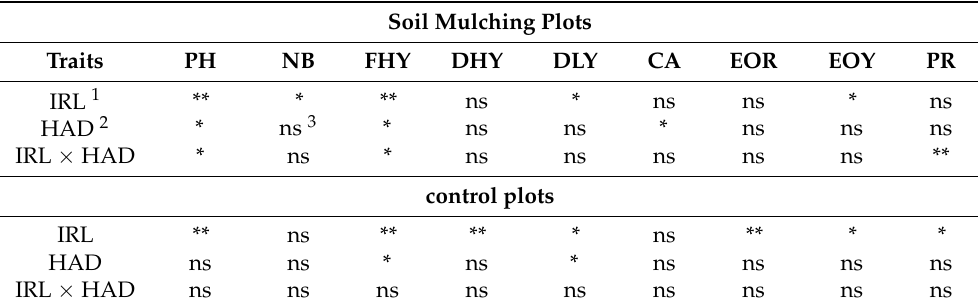
Table 5. Analysis of variance of IRL and HAD on some yield traits and quality characters of O. basilicum L. under soil mulching and control